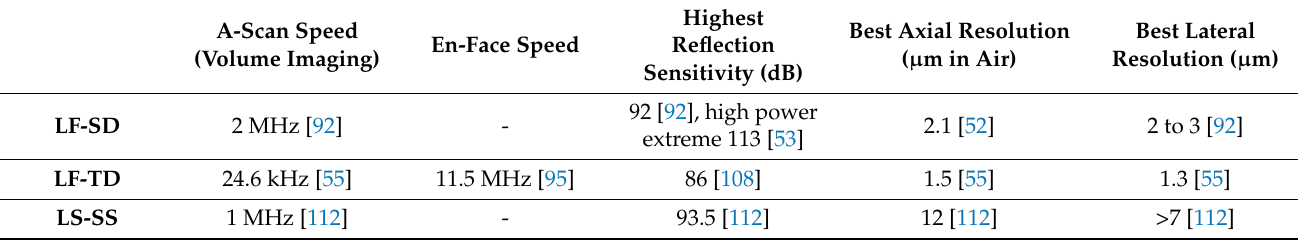
Table 3. Representative values of typical performance achieved with different LF-OCT